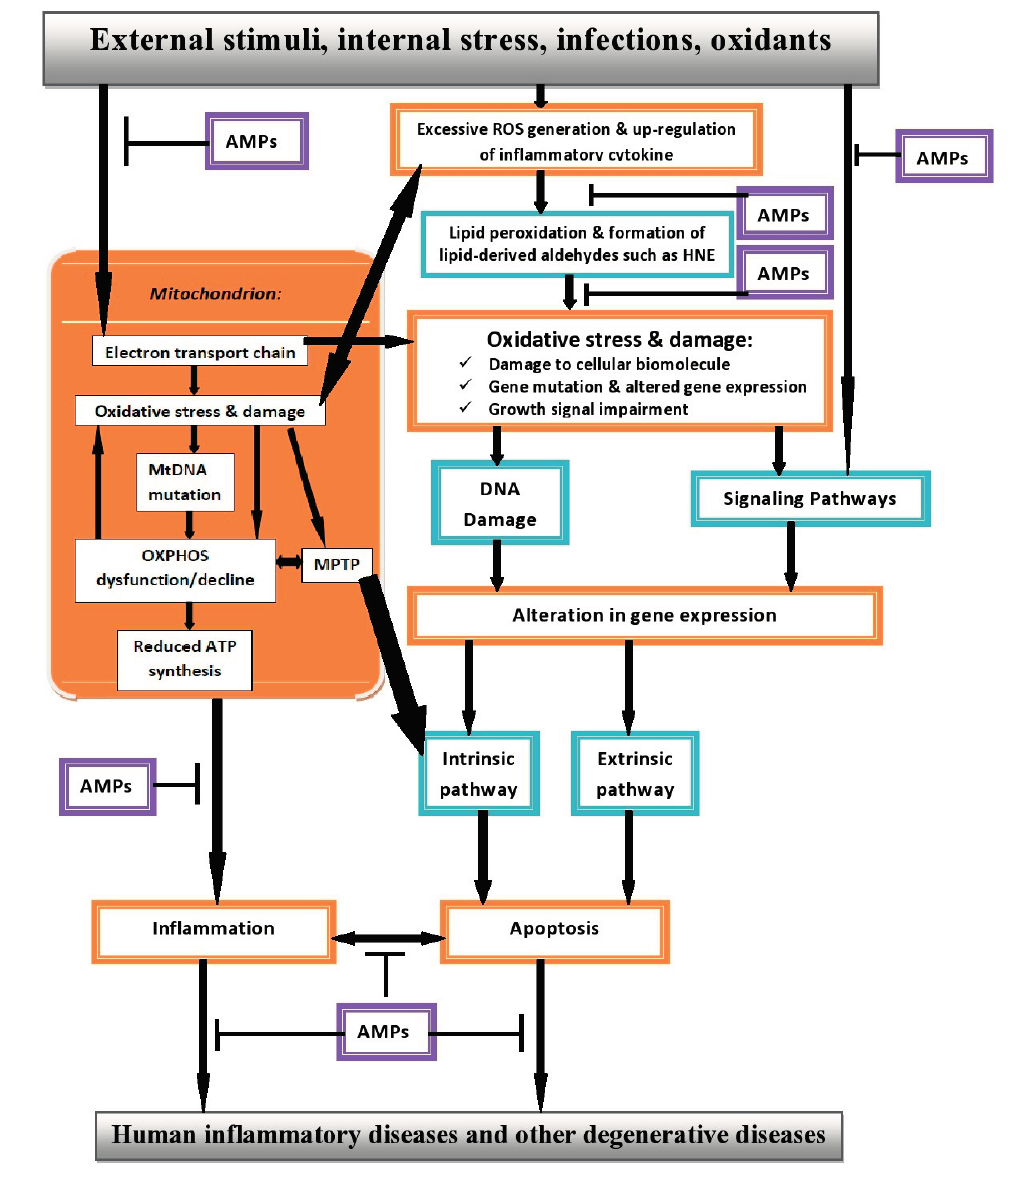
Figure 1. Proposed model of interaction between ROS, apoptosis and AMPs in